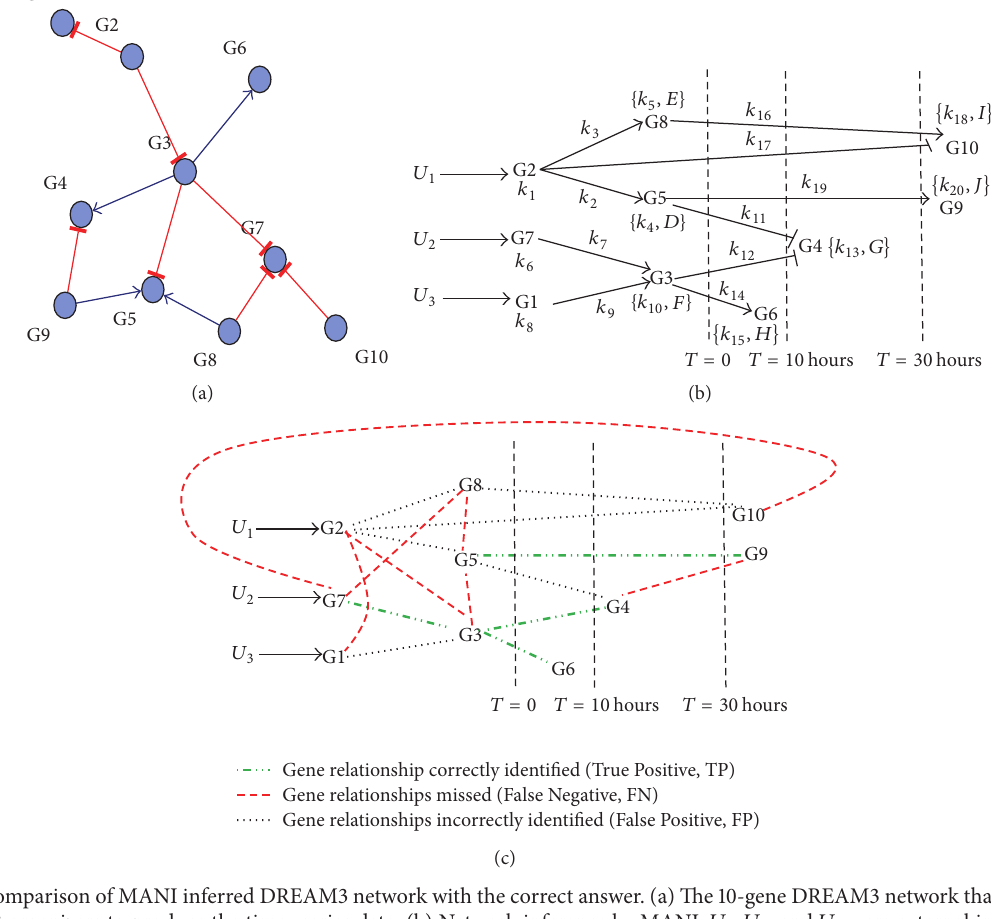
Figure 8: Comparison of MANI inferred DREAM3 network with the correct answer. (a) The 10-gene DREAM3 network that was perturbed by DREAM3 organizers to produce the time- series data. (b) Network inference by MANI. 𝑈 1 , 𝑈 2 , and 𝑈 3 were external inputs. The edges inferred between genes were either stimulating ( → ) or inhibitory ( ⊣ ). The parameters for the different regulatory relationships followed the same convention described in Figure 3. Genes in the network were grouped according to their likely times of activation within the cascade as estimated from the durations of lag observed in their expression data. (c) The accuracy of the DREAM3 network inferred by the MANI approach in (b) was evaluated by comparing it to the correct answer shown in (a). Comparisons were based on the presence or absence of edges between genes rather than directions of interactions. Among the MANI inferred edges in (b), there were 4TPs, 7 FNs, 6 FPs, and 28 True Negatives (TNs).